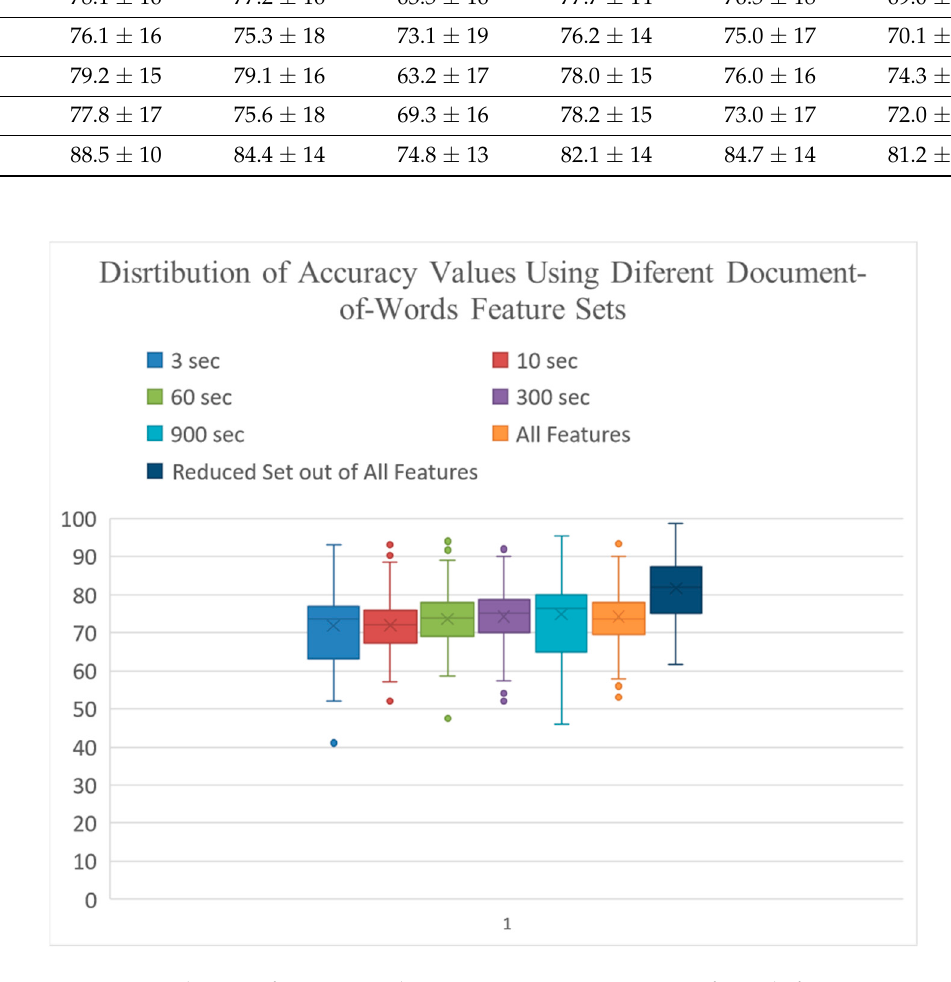
Figure 7. Distribution of accuracy values using various Document-of-Words feature sets.